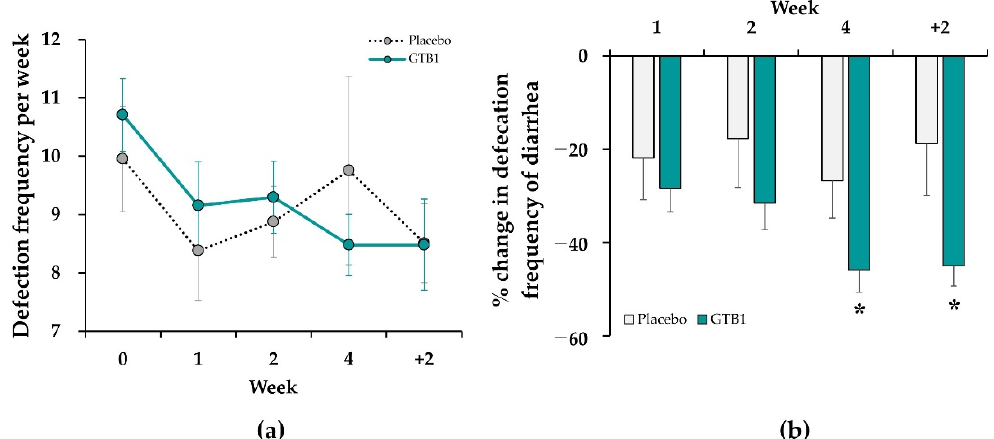
Figure 5. Changes in defecation frequency between GTB1 and placebo groups during intervention period. ( a ) Defecation frequency per week; ( b ) Relative mean change (%) in frequency of diarrhea (BSFS type 6–7). Data are means ± SEM. * p < 0.05 as determined by two-sample t -test.